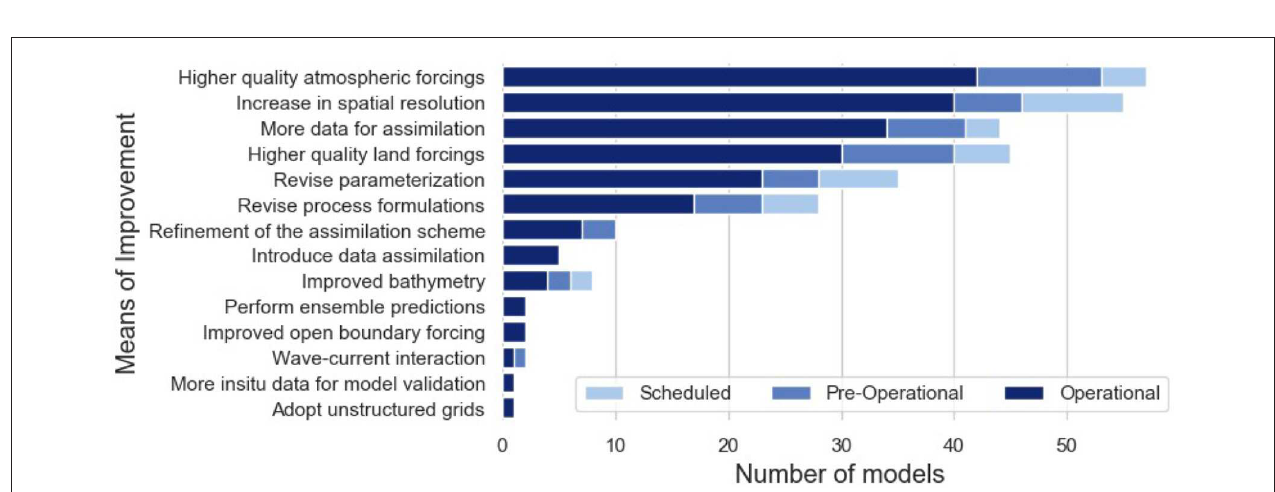
FIGURE 14 | Priority means to improve the accuracy of the operational models.